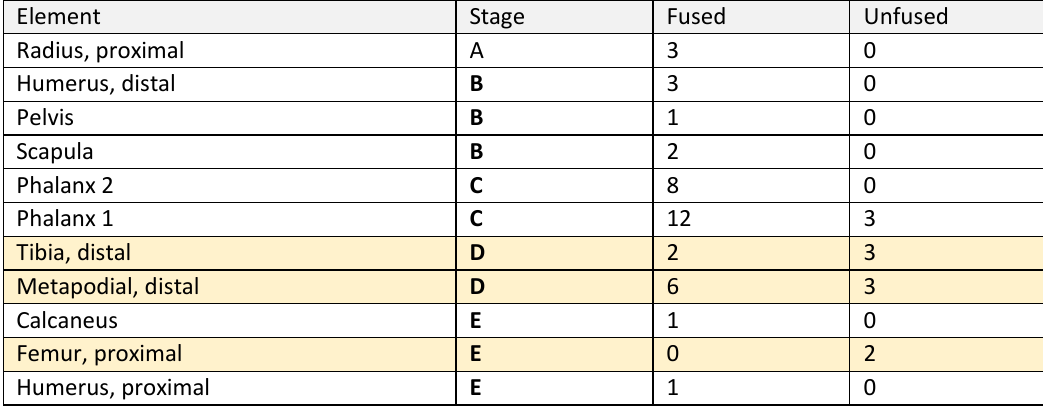
Table 4: Fused and unfused bones of caprines and gazelles for all layers. Fusion stages are for goats